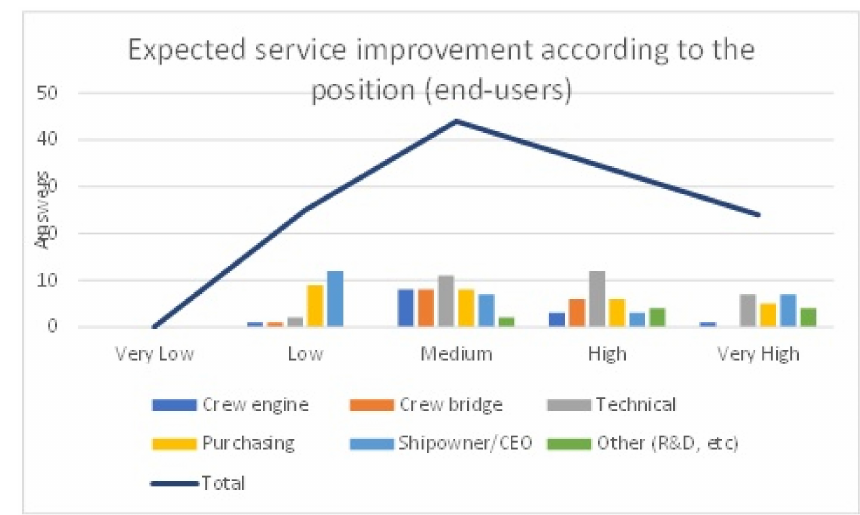
Figure 3. Expected service improvement according to the position.